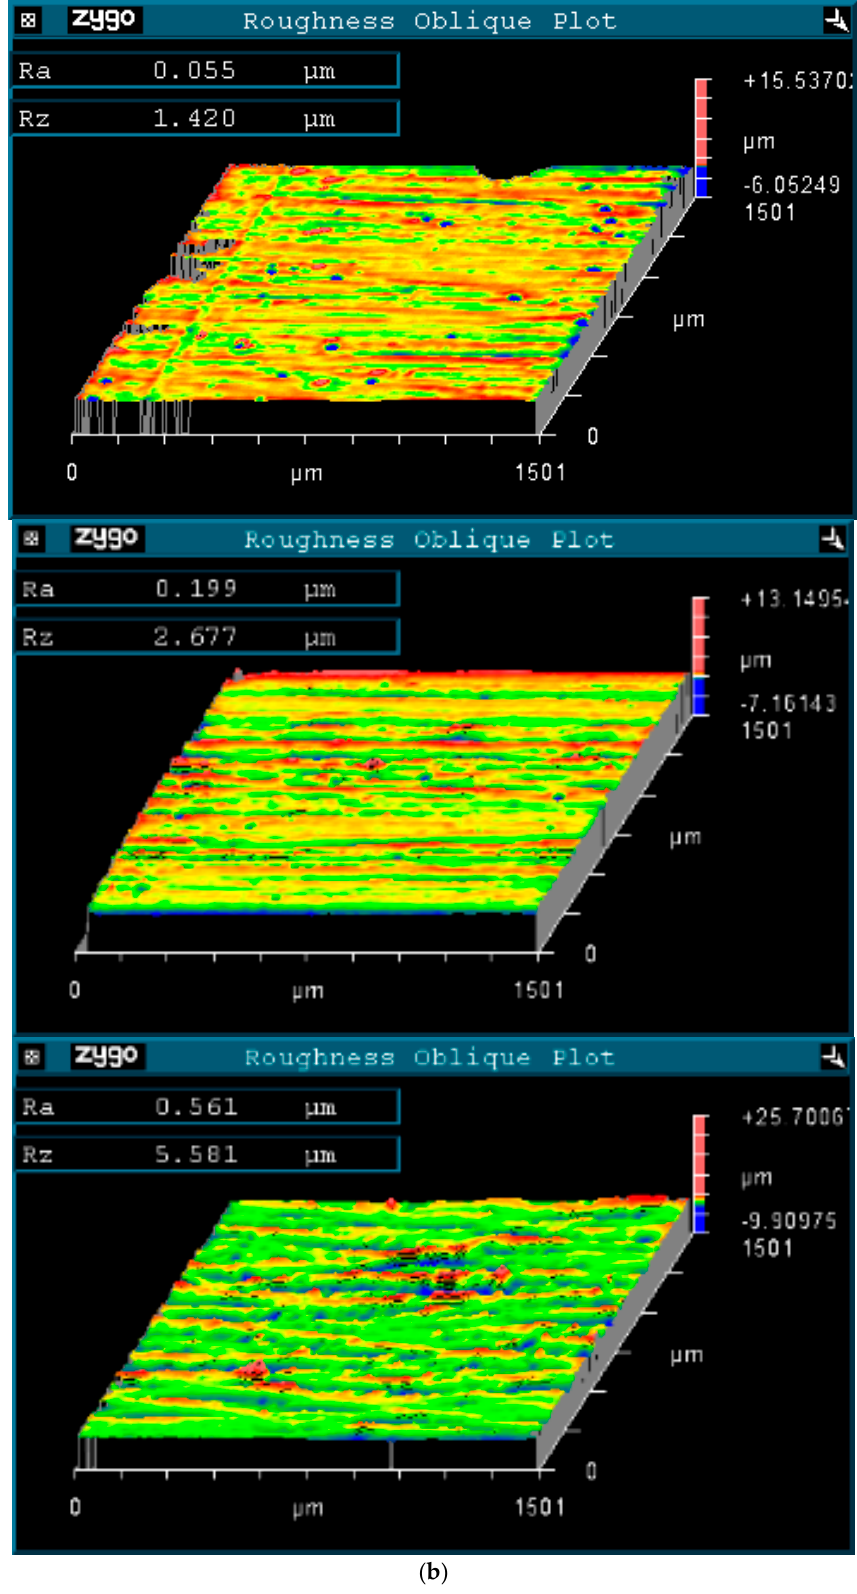
Figure 4. Hole condition showing ( a ) quality of holes at the exit, and ( b ) 3D surface-roughness topography at the exit showing average R a and R z values (from left to right: using TiN/TiAlN, TiAlN, and TiN coating).